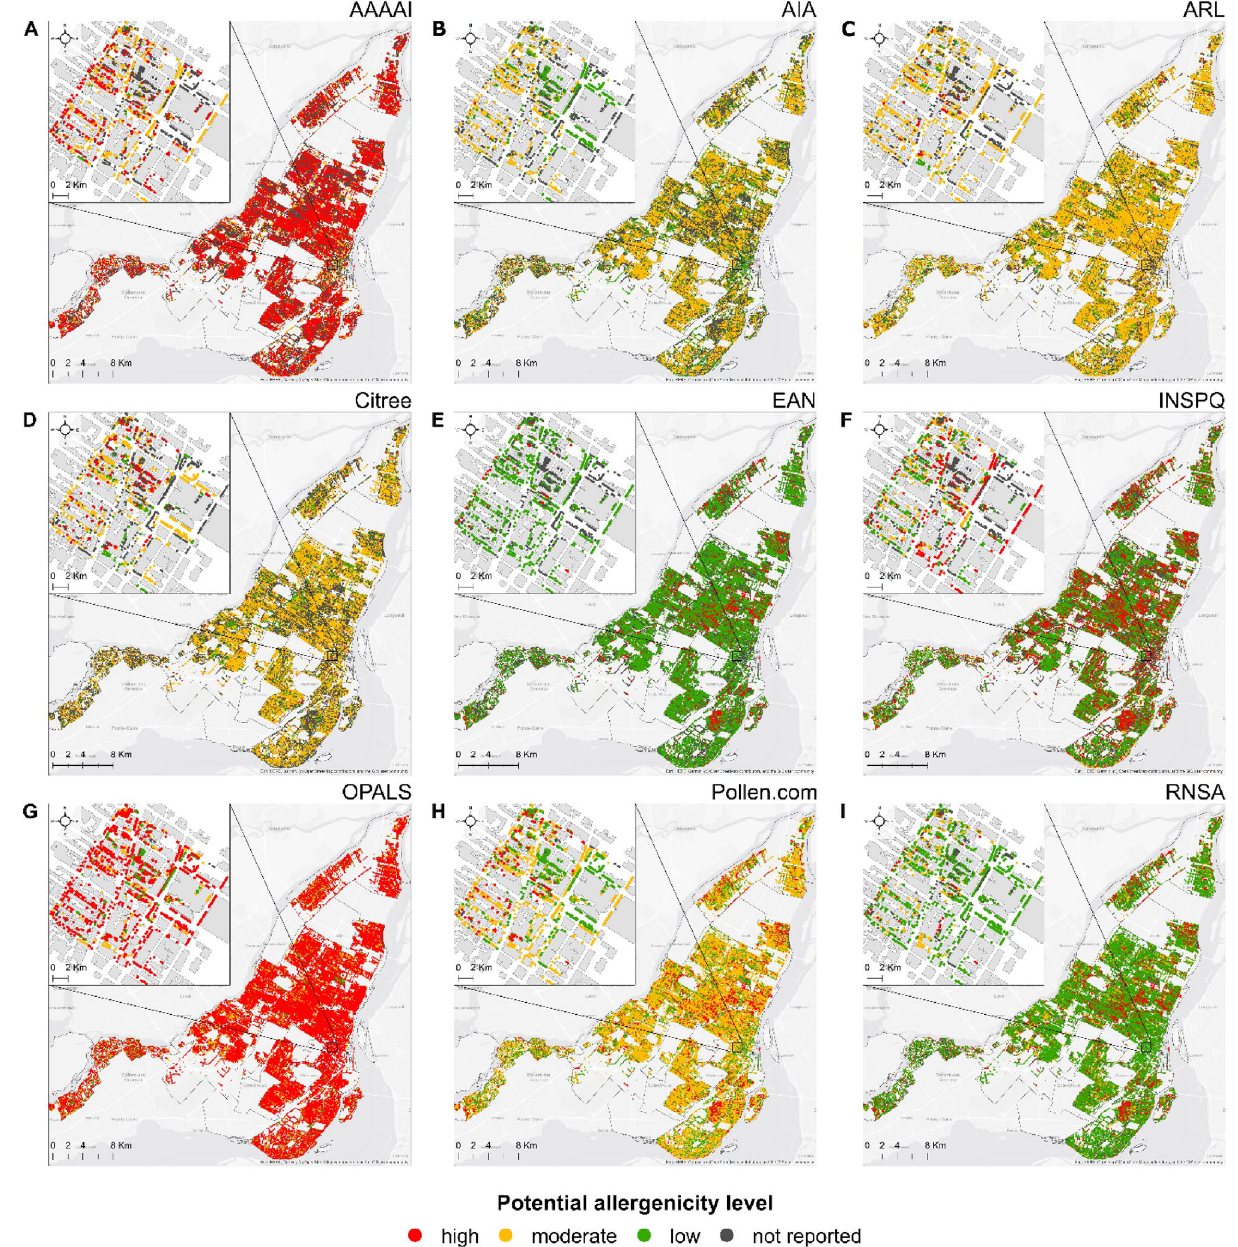
alphabetical order: ( A ) the American Academy of Allergy, Asthma & Immunology (AAAAI); ( B ) the vegetation guidance by the Italian Association of Aerobiology (AIA); ( C ) Canada’s Aerobiology Research Laboratories (ARL); ( D ) the Citree’s library; ( E ) the European Aeroallergen Network (EAN); ( F ) the National Institute of Public Health in Quebec (INSPQ); ( G ) the Ogren Plant Allergy Scale (OPALS); ( H ) the Pollen.com’s library; and ( I ) the vegetation guidance by the French aerobiological monitoring network (RNSA). Each dot represents one tree. The inset shows an enlarged view of a central neighborhood in the city. Data sources are presented in Table 1. Maps were created in ArcMap 10.7.1 (http:// www. esri.